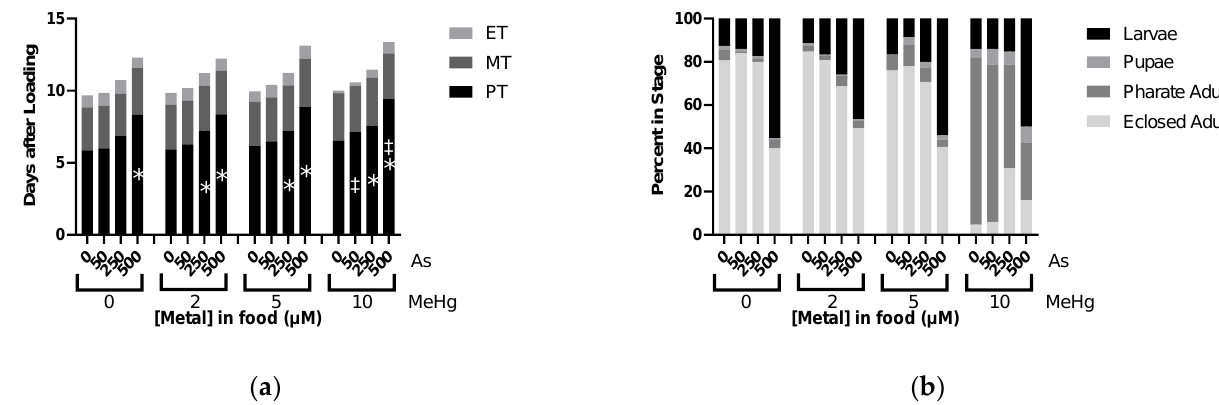
Figure 7. Effects of MeHg and As mixtures on Developmental Time Course. All data from same experiment using CS larvae dosed with indicated concentrations of MeHg and As in food. ( a ) Developmental Timing: average time spent in each stage across different treatment conditions. ( b ) Developmental Endpoints: average of individuals remaining in each stage of development at endpoint of 16 days. (* p < 0.05 compared to fixed value of MeHg at 0 µM As, ‡ p < 0.05 compared to fixed value of As at 0 µM MeHg, two-way ANOVA).